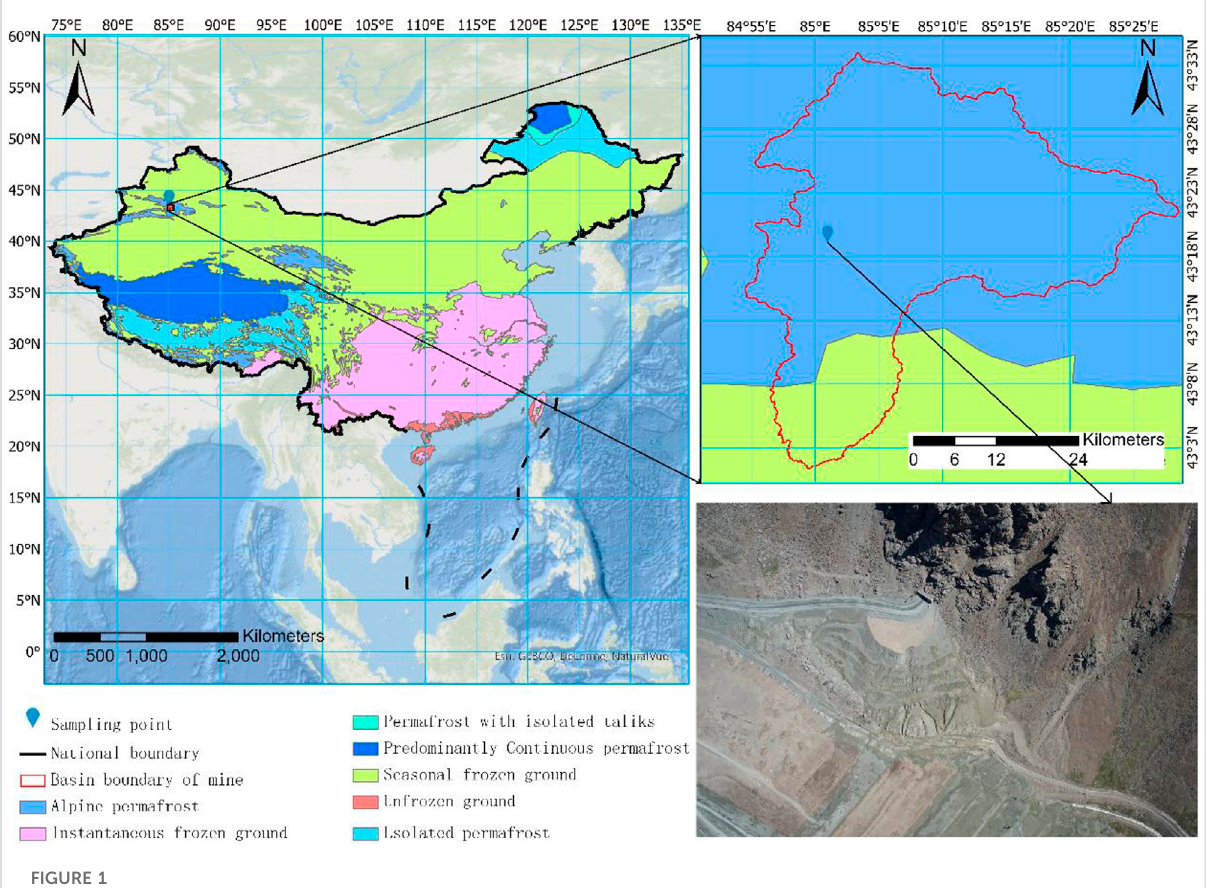
FIGURE 1 Schematic of the sampling location.